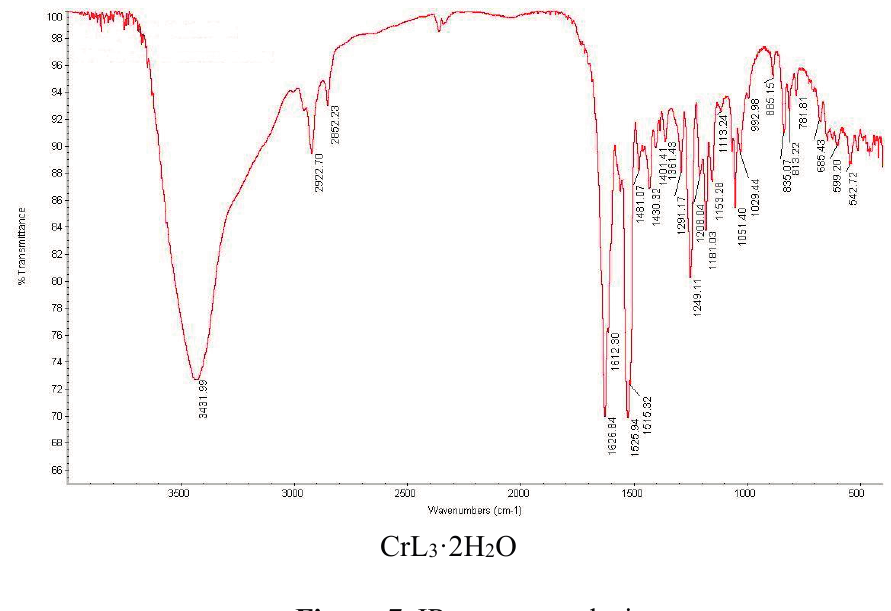
Figure 7. IR spectra analysis.